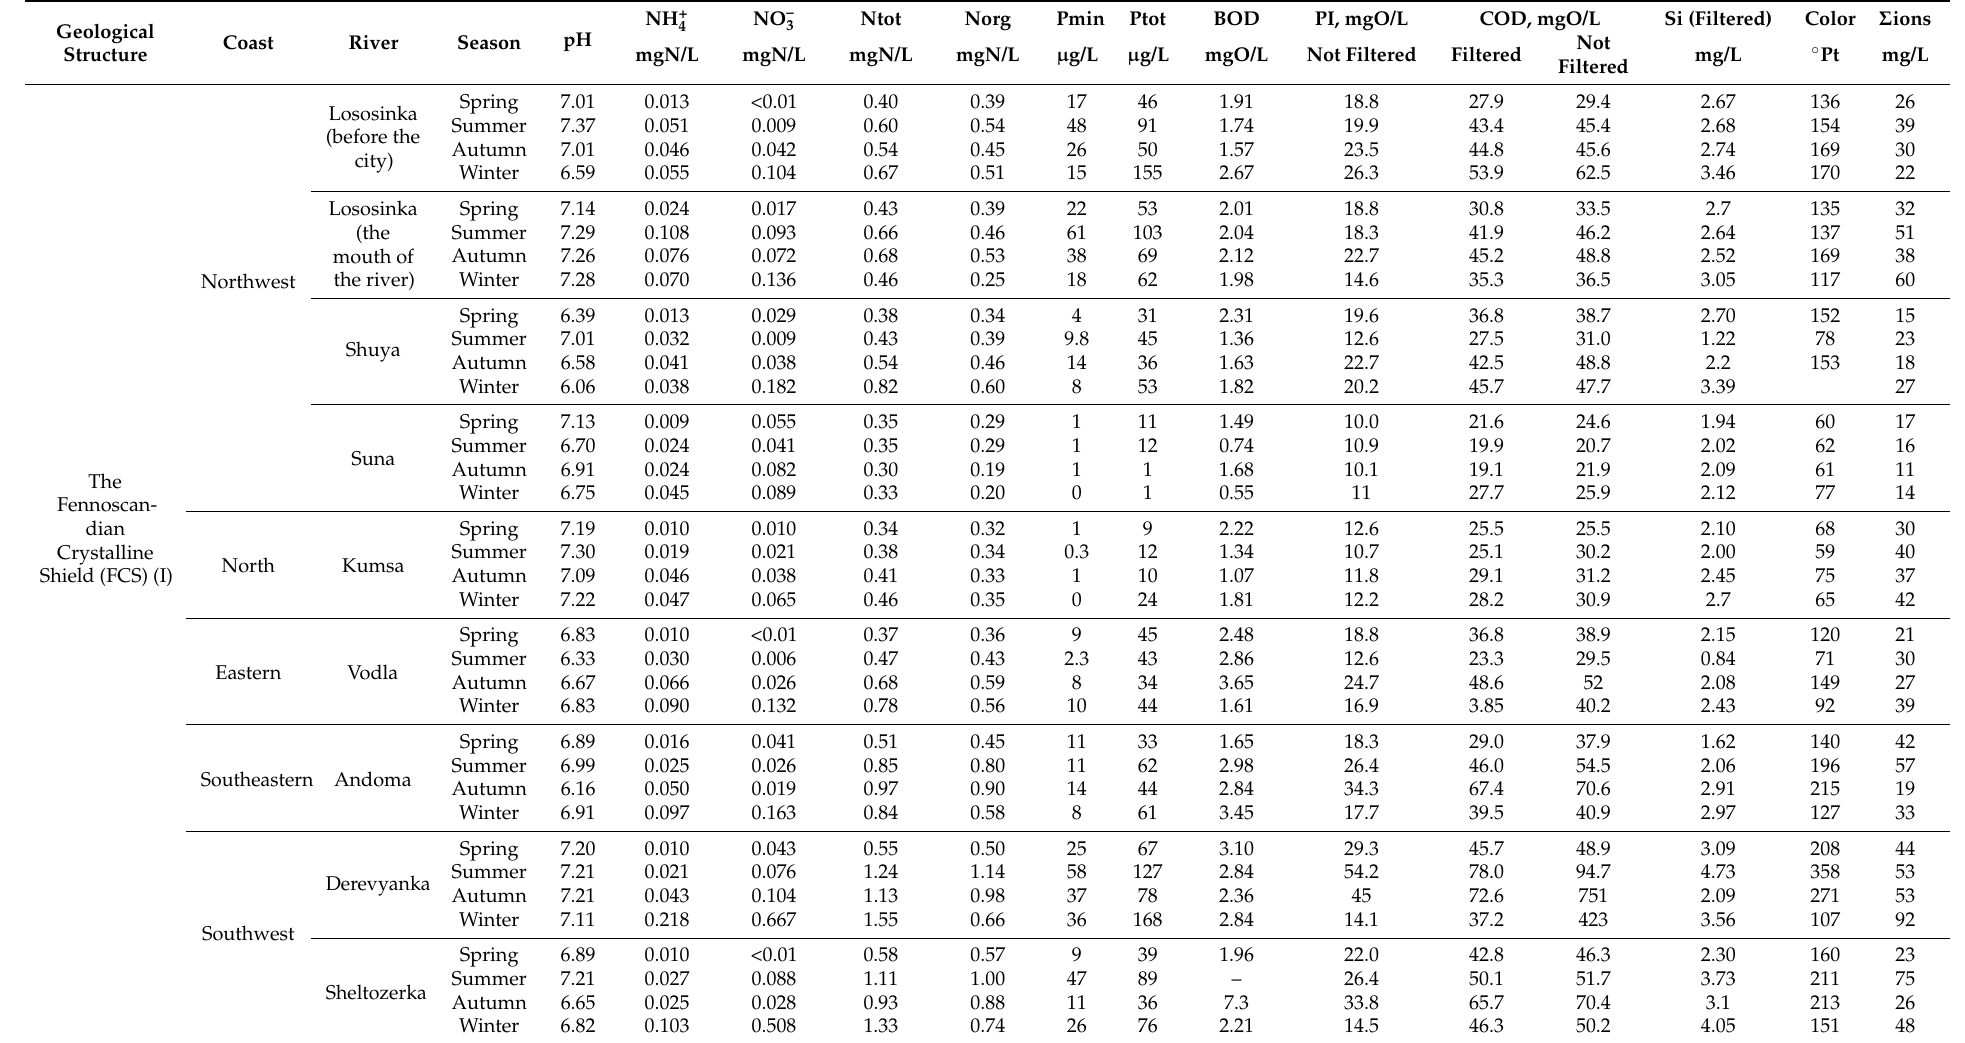
Table 2. Chemical composition of the water of the tributaries of Lake Onego («–»—no data). Geological